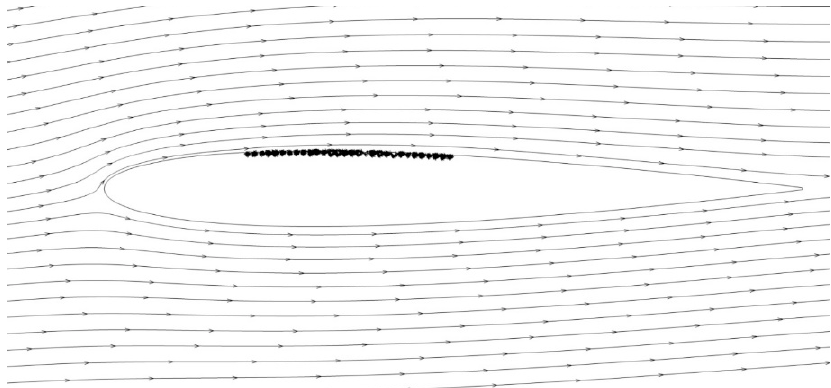
Figure 17. 4° angle of attack, pressure distribution of grooves on the pressure side.